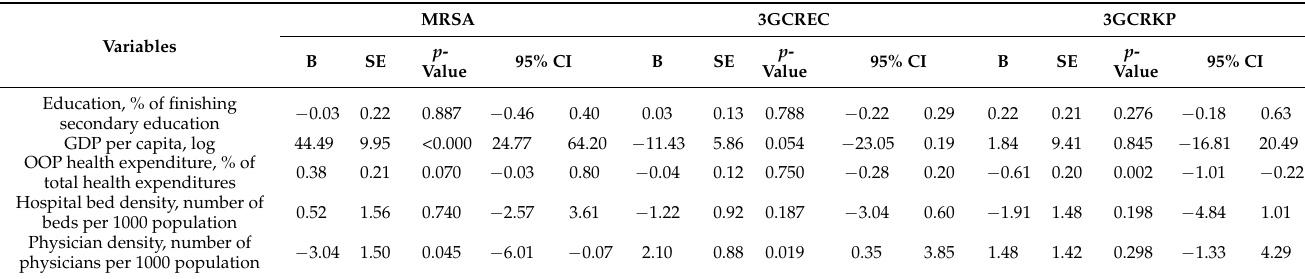
Table 3. Effect of variables on the MRSA, 3GCREC, and 3GCRKP prevalence among 30 provinces in mainland China (excluding the Tibet autonomous